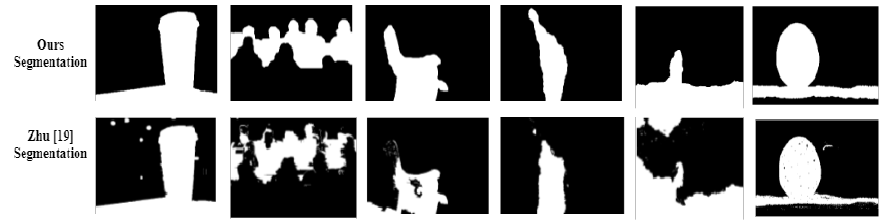
Figure 8. Binary defocus segmented comparison along with Zhu et al.